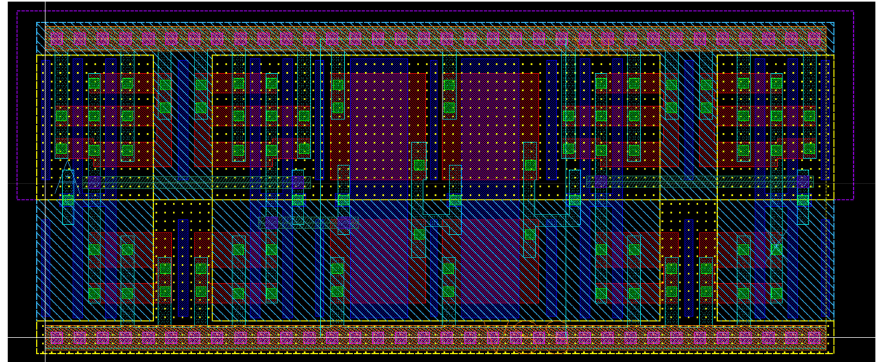
Figure 5. The layout of the proposed Abacus-C time-delay